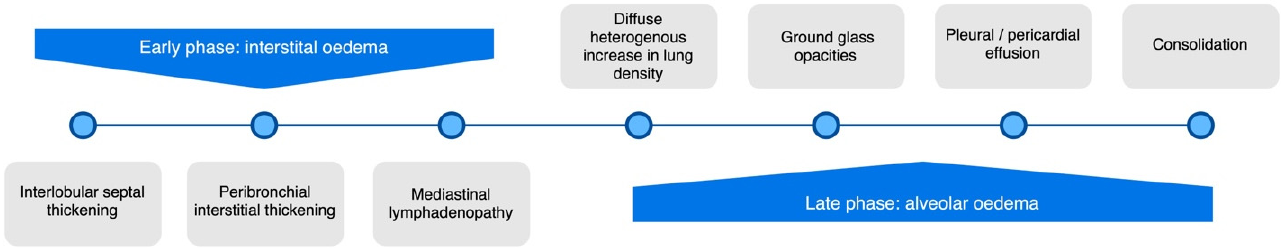
Figure 9. The following stages of pulmonary abnormalities related to HF in chest CT. More information in the text.